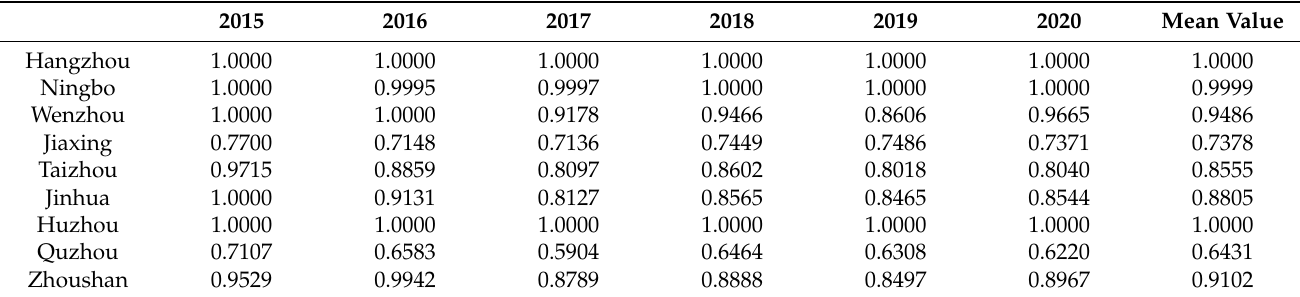
Table 2. Calculation results of low-carbon economic efficiency of nine prefecture-level cities in Zhejiang